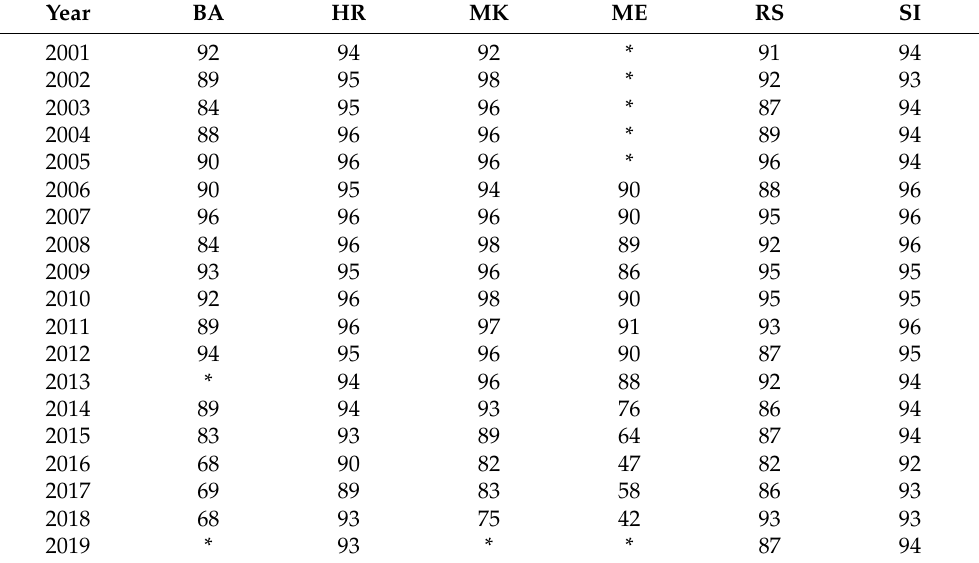
Table 3. Measles-containing vaccine first dose (%) in Croatia and neighboring countries in the years 2001 to